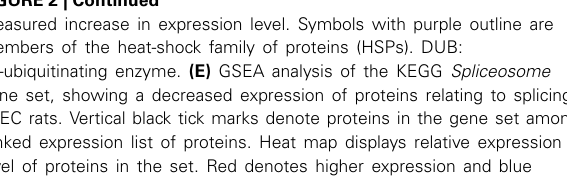
Table 3 | A selection of environmental enrichment-regulated protein sets from the GSEA